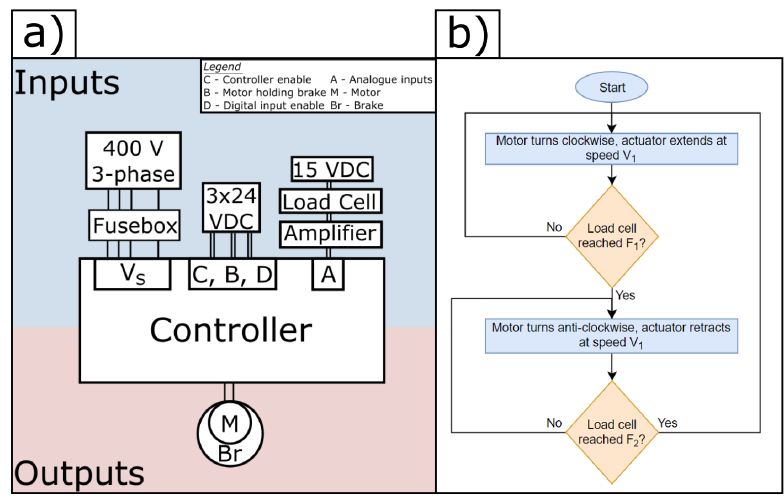
Figure 7. ( a ) circuit diagram of controller setup; ( b ) flow chart of simple load cell feedback control program. F 1 , F 2 and V 1 are force and speed values set by